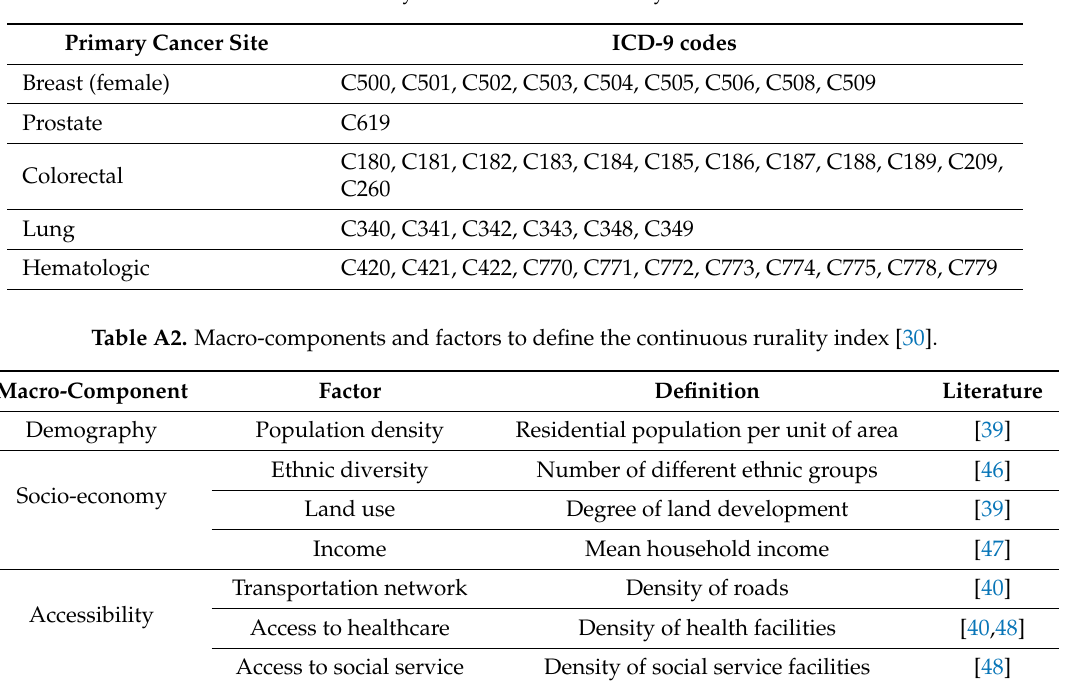
Table A1. Primary cancer site definitions by ICD-9 codes.